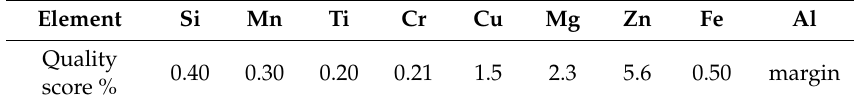
Table 5. The chemical composition of the 7075Al.